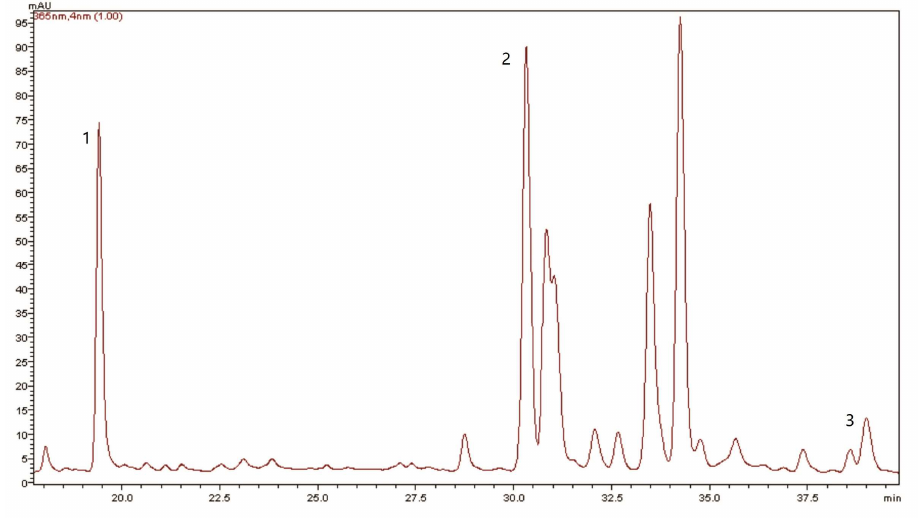
Figure 1. Typical HPLC chromatogram of rabbiteye blueberry leaves, injected volume 40 µL, at λ = 365 nm. Peaks: 1: chlorogenic acid; 2: rutin; 3: quercetin